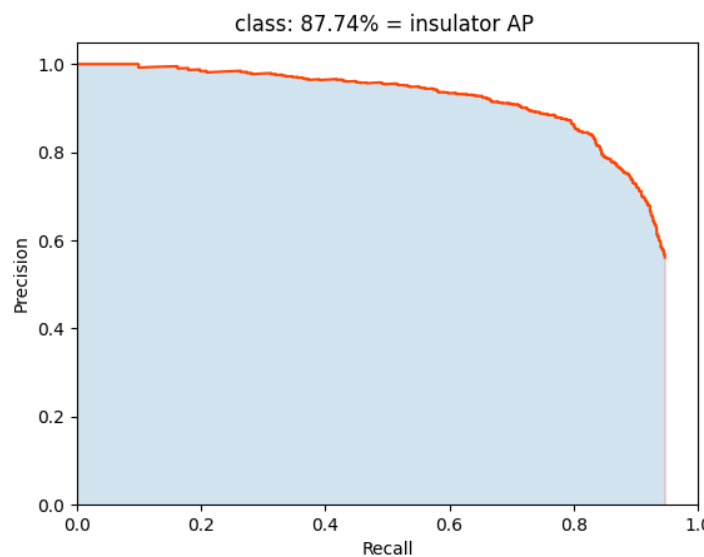
Figure 8. Precision–recall curve graph under the VGG16 backbone